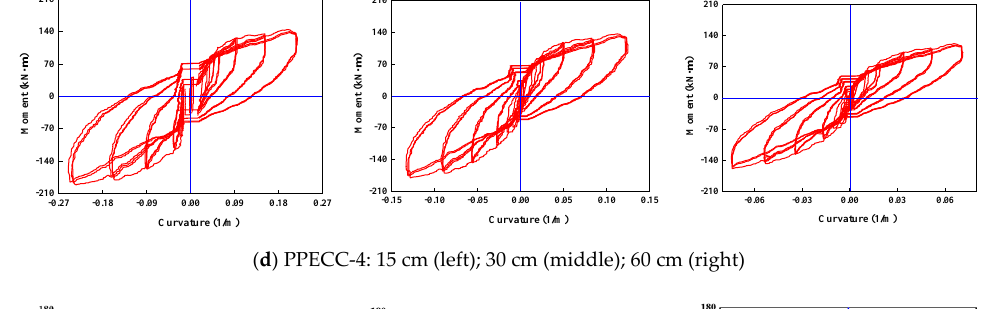
( d ) PPECC-4: 15 cm (left); 30 cm (middle); 60 cm (right)